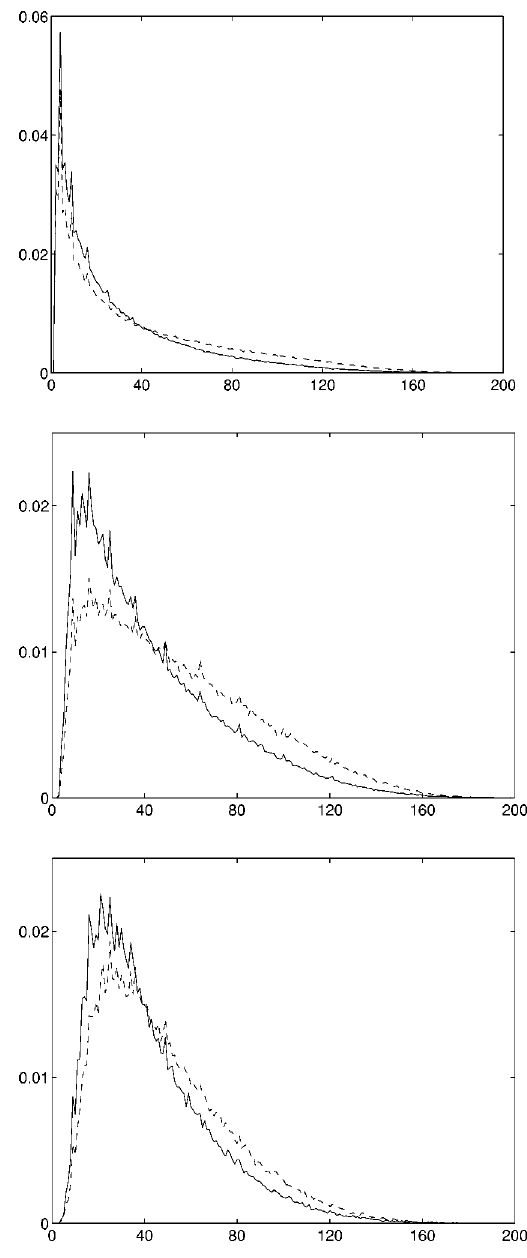
Fig. 5. Average normalized histograms of the length of line segments s for some tolerances, T WD = 1 : 25,3 : 25, and 8 : 5. The histograms are the average over all cells in the normal (- -) and tumour (—) classes, and were extracted from the second 10% peripheral seg- ments of the cell